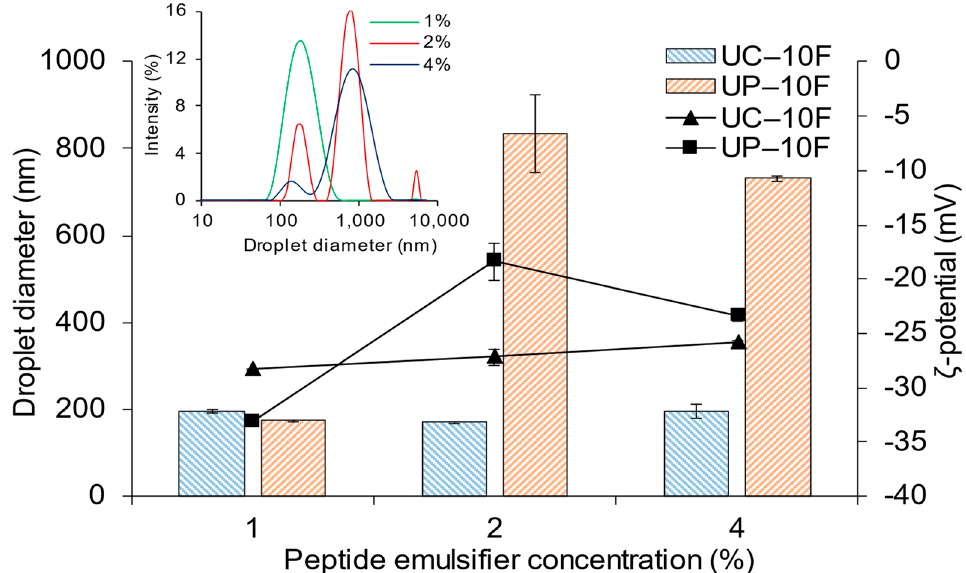
Figure 1. Effect of peptide concentration on the droplet diameter and ζ -potential of nanoemulsions or emulsions formed with the UC–10F chymotrypsin and UP–10F pepsin WPI fractions. Legend: droplet size, bars; ζ -potential, lines. Insert, upper left: droplet size distribution of UP–10F (nano)emulsions at 1, 2, and 4% emulsifier concentrations.